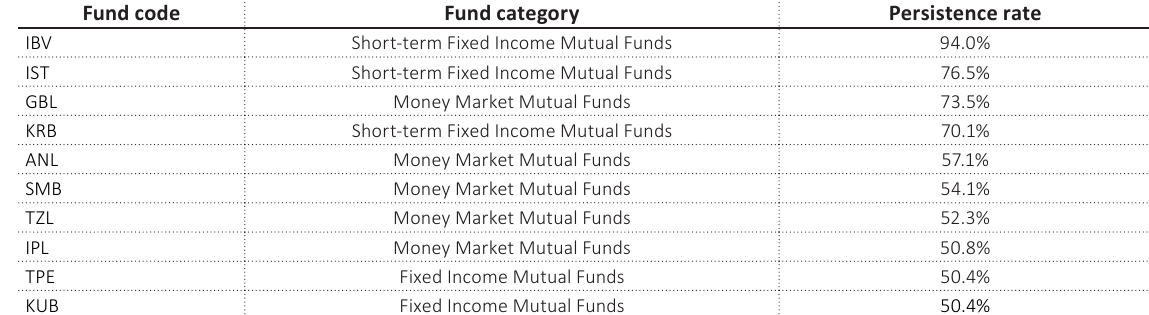
Source: Authors’ calculations.